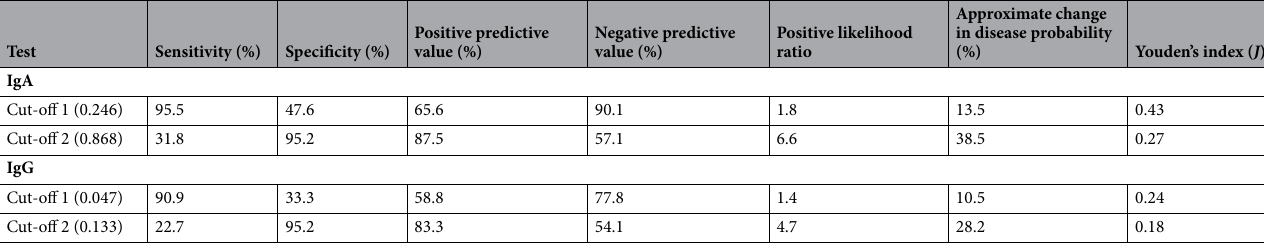
Table 3. Diagnostic accuracy of F. nucleatum IgA and IgG ELISA test in colorectal cancer.